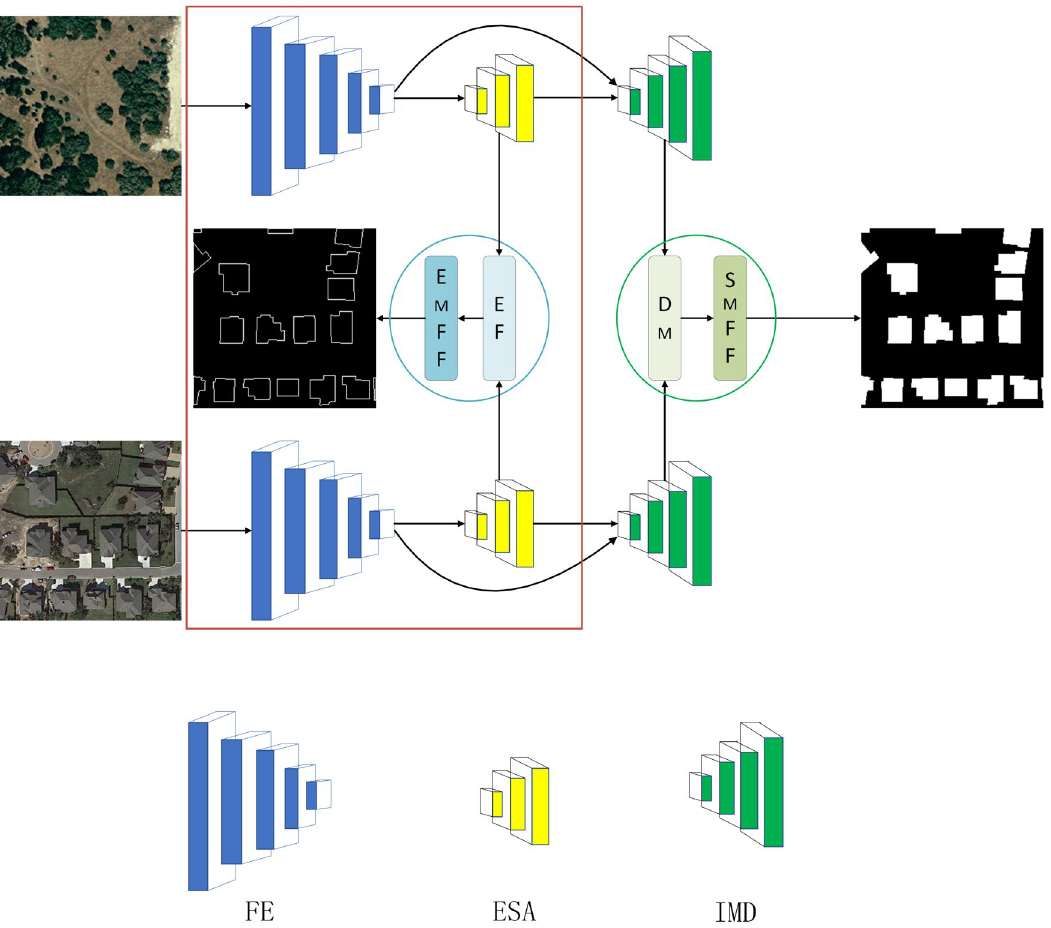
Figure 1. Overall architecture of EGCTNet. The red box is the edge detection branch, FE represents the fusion encoder, ESA represents edge self-attention, IMD represents the intermediate decoder, the blue circle is the edge decoder, EF represents edge fusion, EMFF represents edge multiscale feature fusion, the green circle is the change decoder, DM represents the differential module, and SMFF represents semantic multiscale feature fusion.